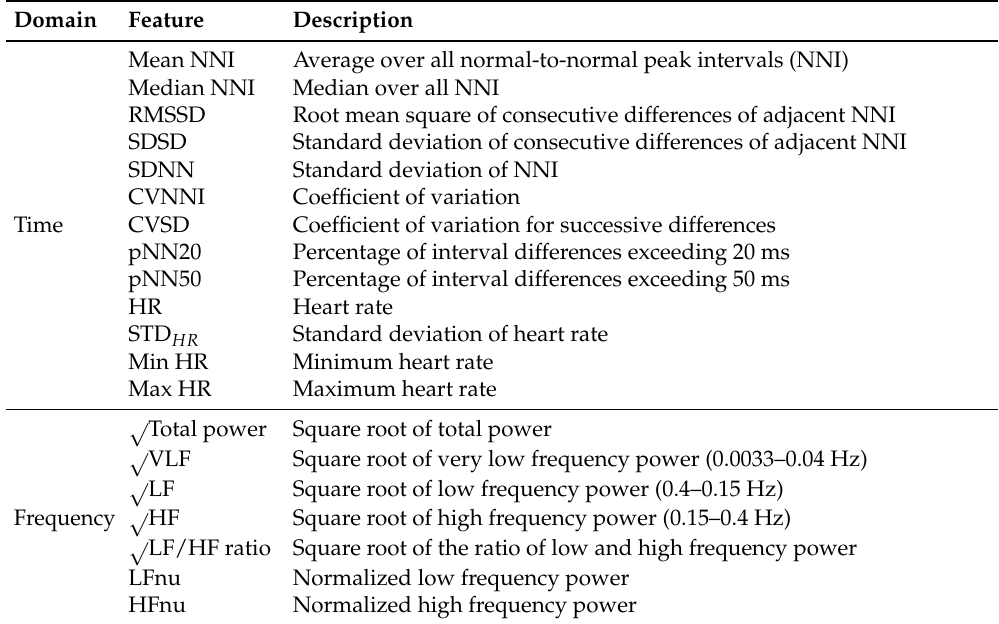
Table 2. Heart rate variability features explained.